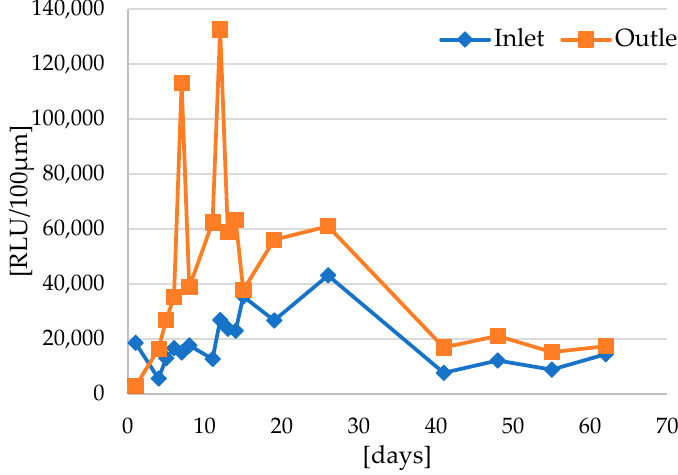
Figure 7. The results of the ATP analysis in the inflow and outflow of the system.